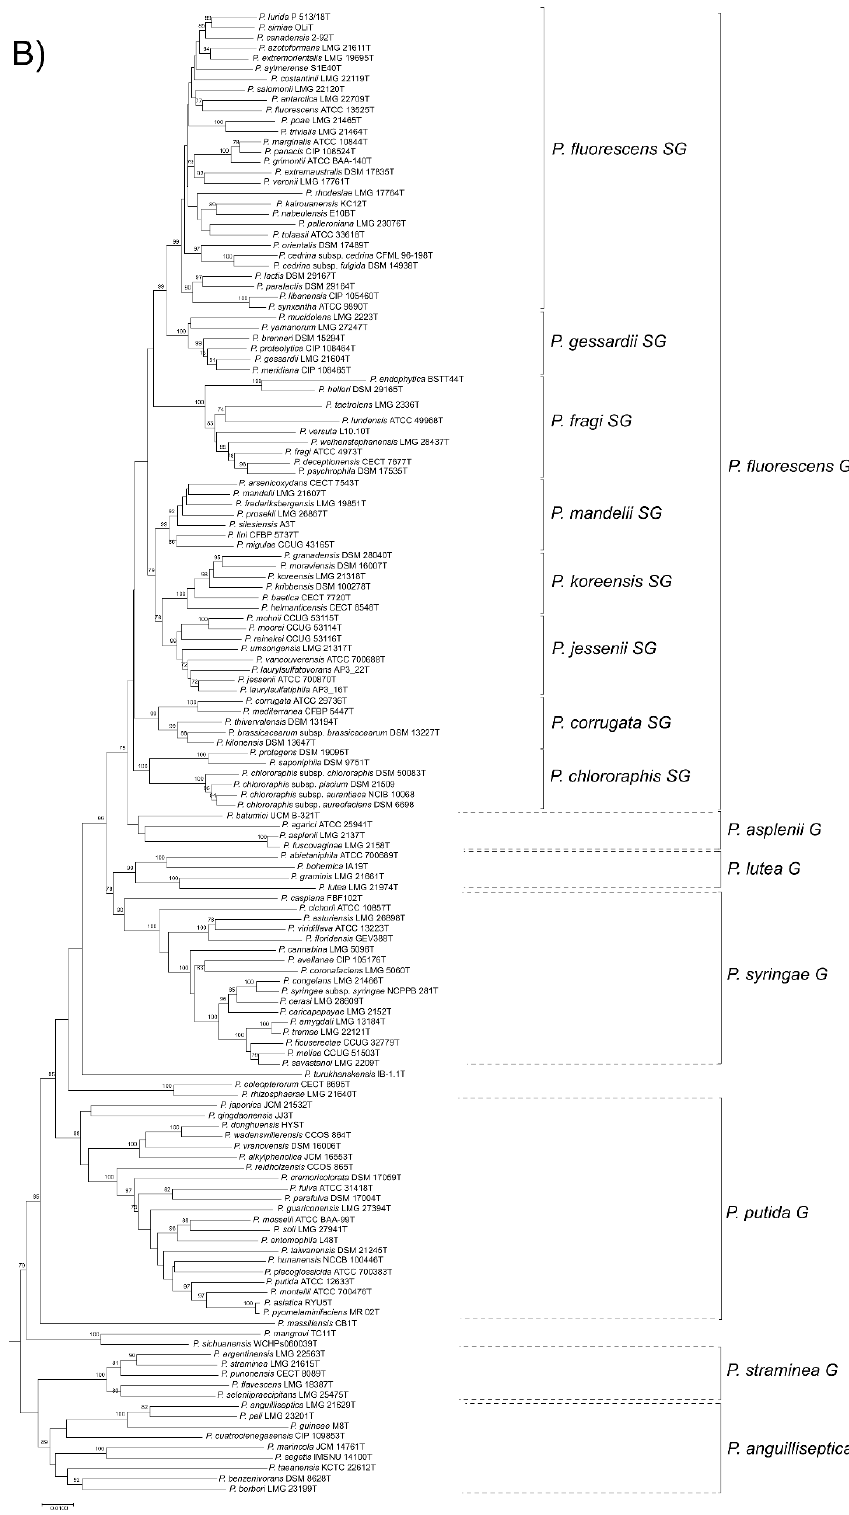
Figure 1. Phylogenetic tree based on the 4-genes MLSA for the 227 species or subspecies type strains analyzed using neighbor-joining reconstruction with Jukes–Cantor distances. ( A ) P. aeruginosa and P. pertucinogena lineages. ( B ) P. fluorescens lineage. Bootstrap values higher than 70% are indicated on the nodes. Bars indicate sequence divergence.